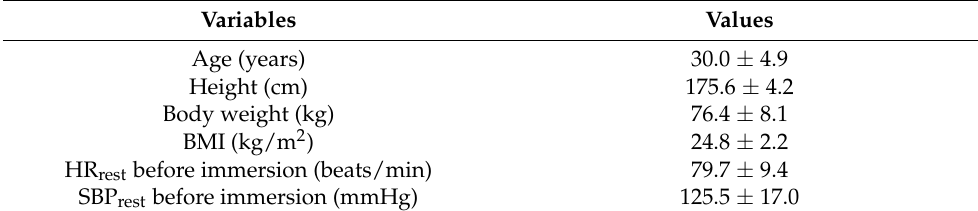
Table 1. Participants’ demographics and baseline